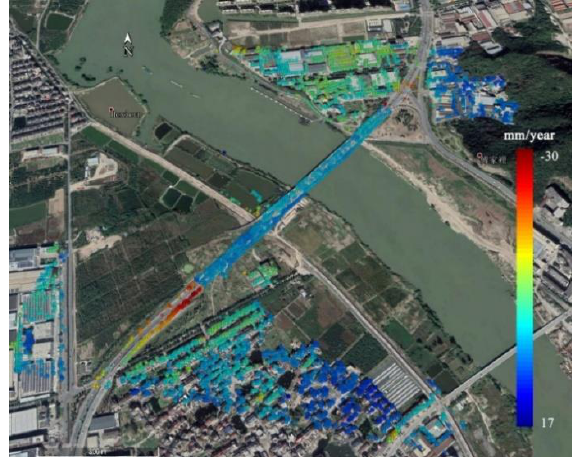
Figure 5. The deformation velocity obtained from the primary selection